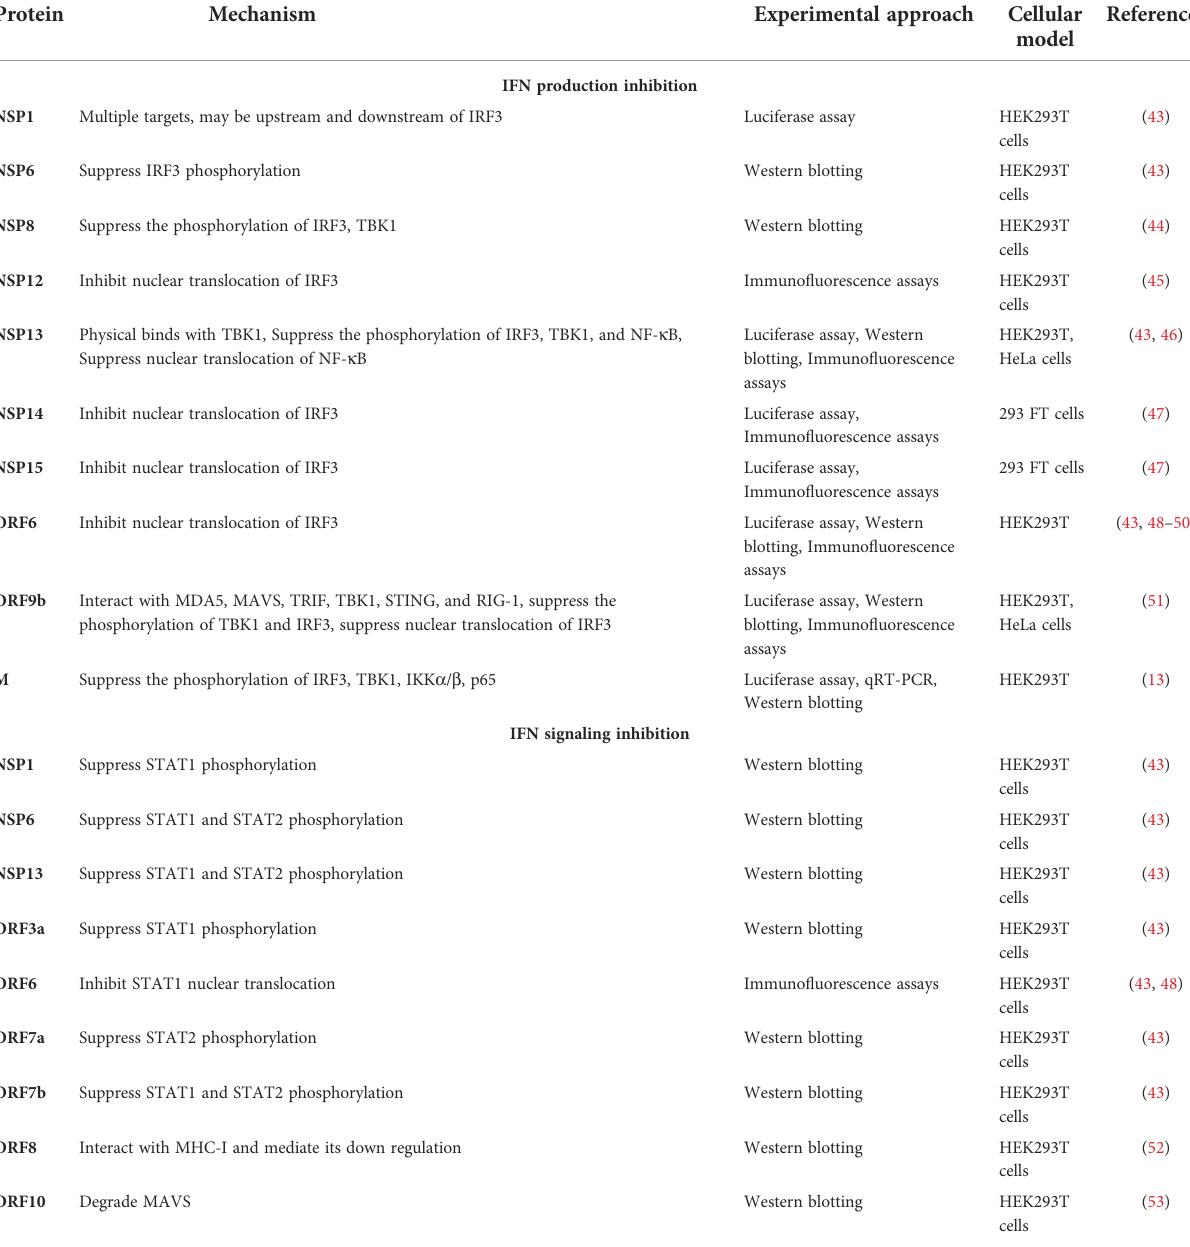
TABLE 1 SARS-CoV-2 proteins interfering with IFN induction and